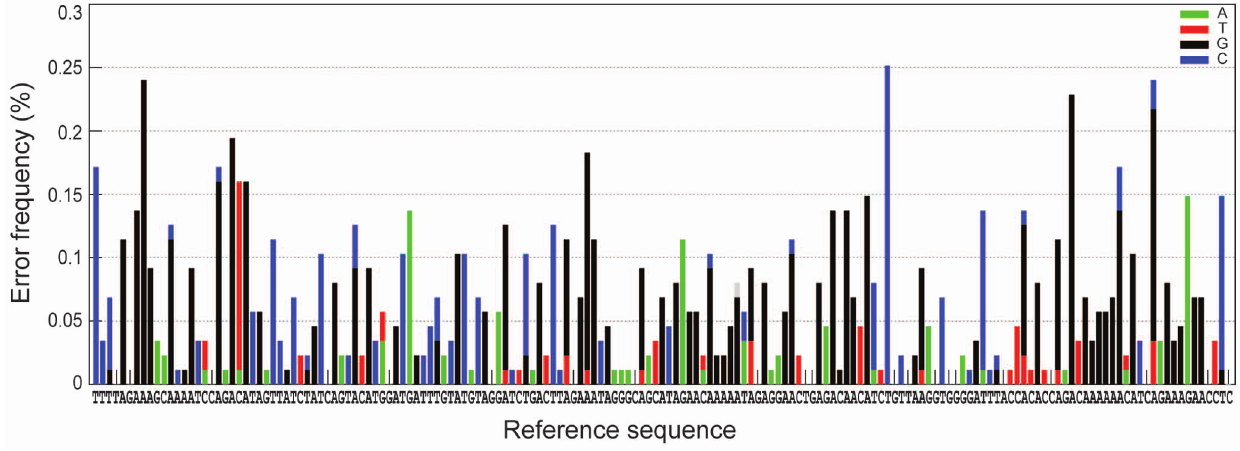
Figure 3. Site-specific error frequencies in percent (%) in cleaned UDPS data obtained in the forward sequencing direction of run 1. All sequencing errors were substitutions since all deletions and insertions were removed by the data cleaning procedure. The bars are color-coded according to the type of substitution error. Homopolymeric regions are shaded.